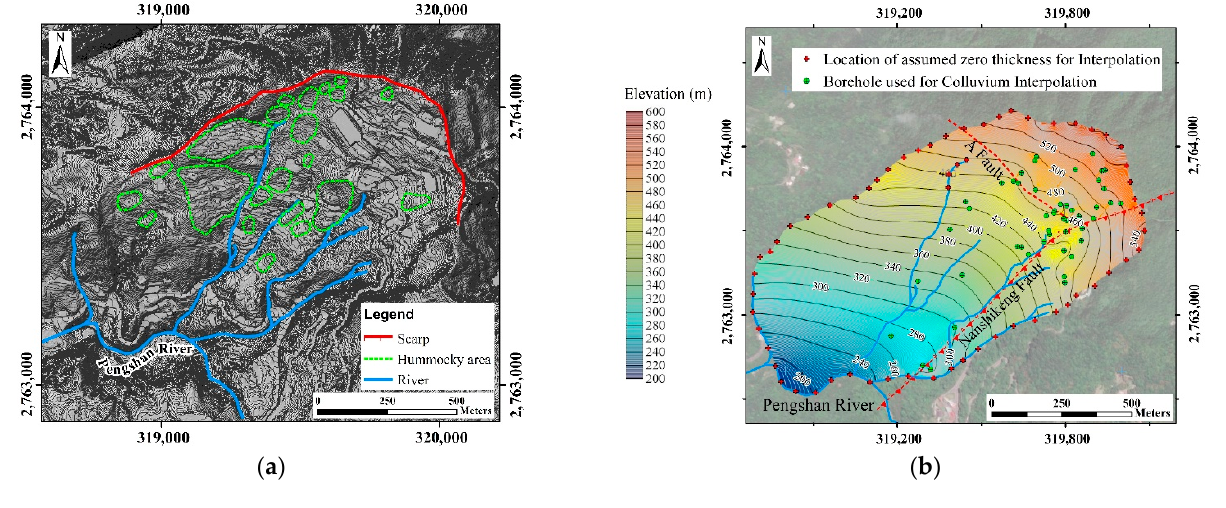
Figure 4. Topography-constrained Kriging map of the lower colluvium boundary. Data were synthesized from the boreholes and topographical analysis: ( a ) Hummocky terrain in the study area; and ( b ) Kriging map of elevation of the interface between the colluvium and the bedrock.